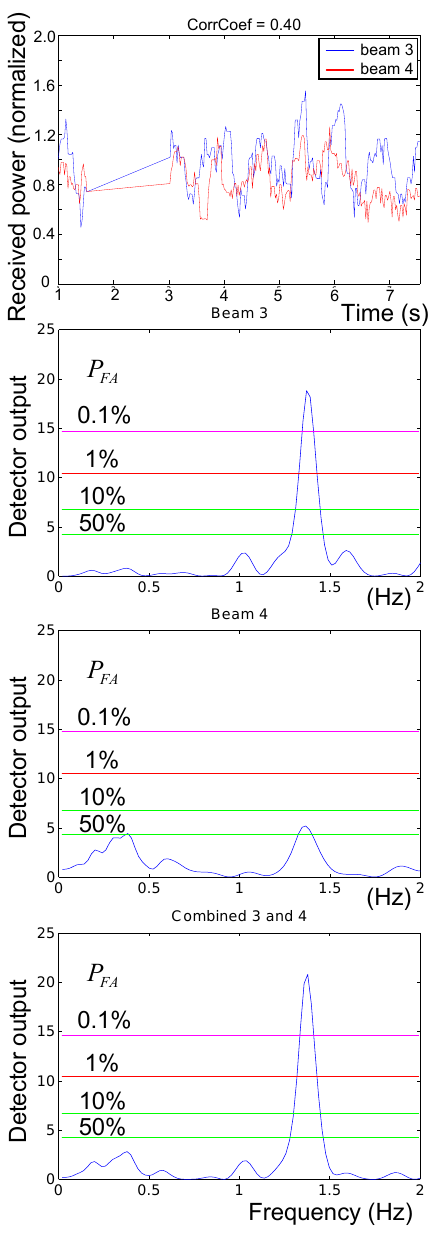
Fig. 6. Weighted time series and detector output for beams 3 and 4, and for the combined time